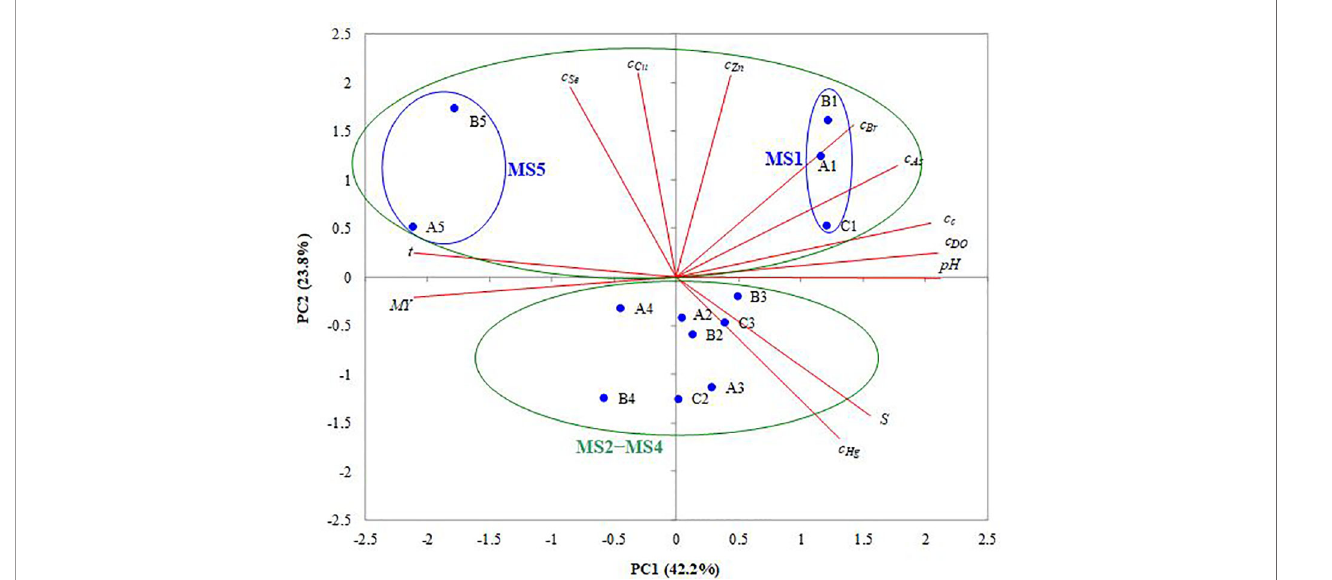
FIGURE 5 | PCA bi-plot (projections of variables and samples on the factor-plane PC1 − PC2).